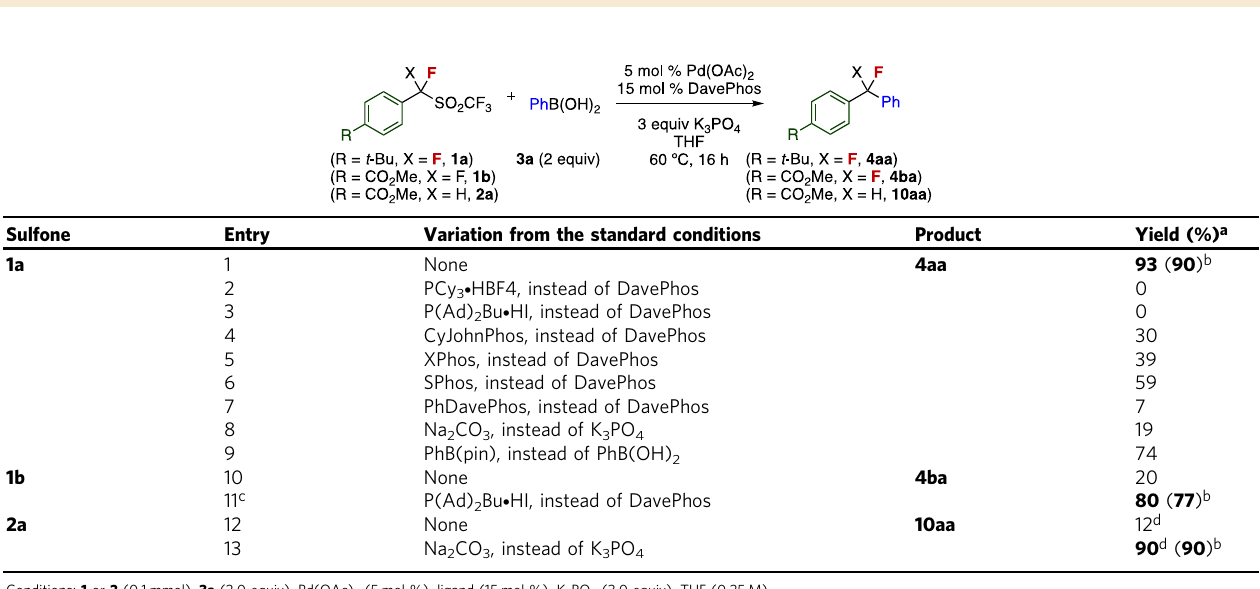
Table 1 Optimization of Pd-catalyzed desulfonylative Suzuki − Miyaura cross-coupling of 1 and 2